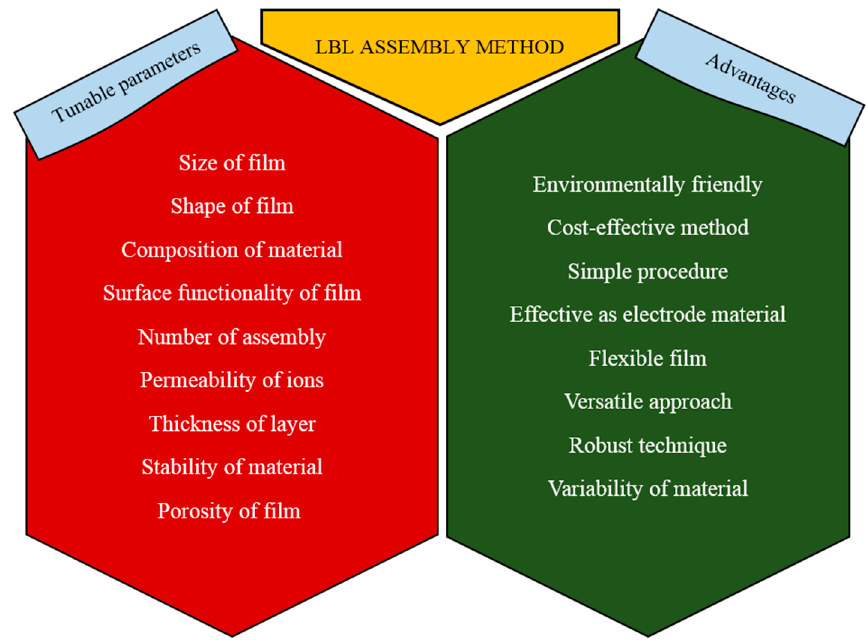
Figure 5. Characteristics and controllable properties of layer-by-layer (LBL) assembly method.